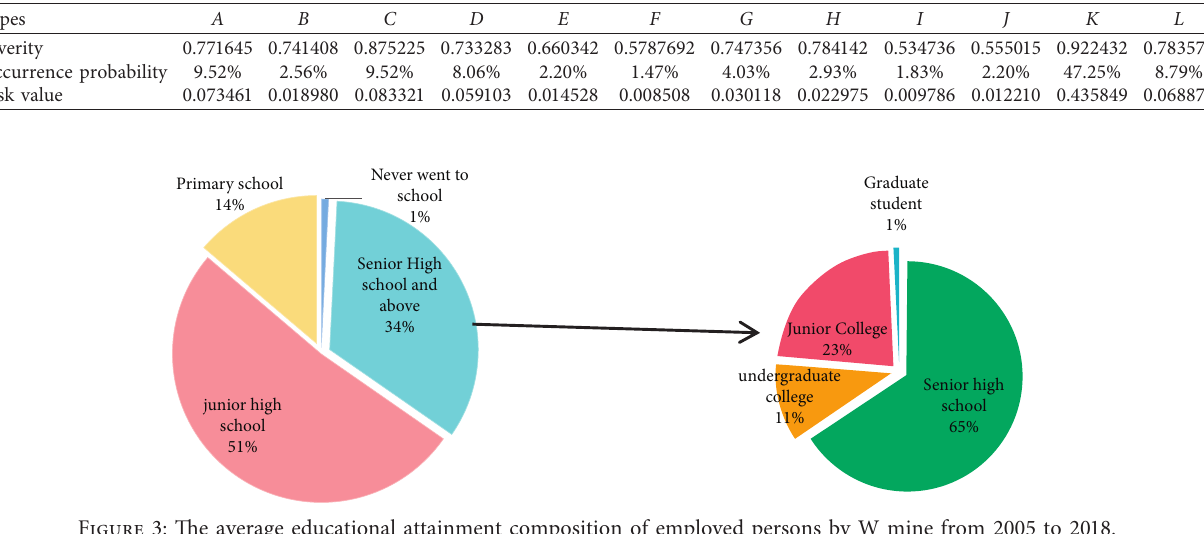
Table 7: The risk value of miners’ unsafe behavior.